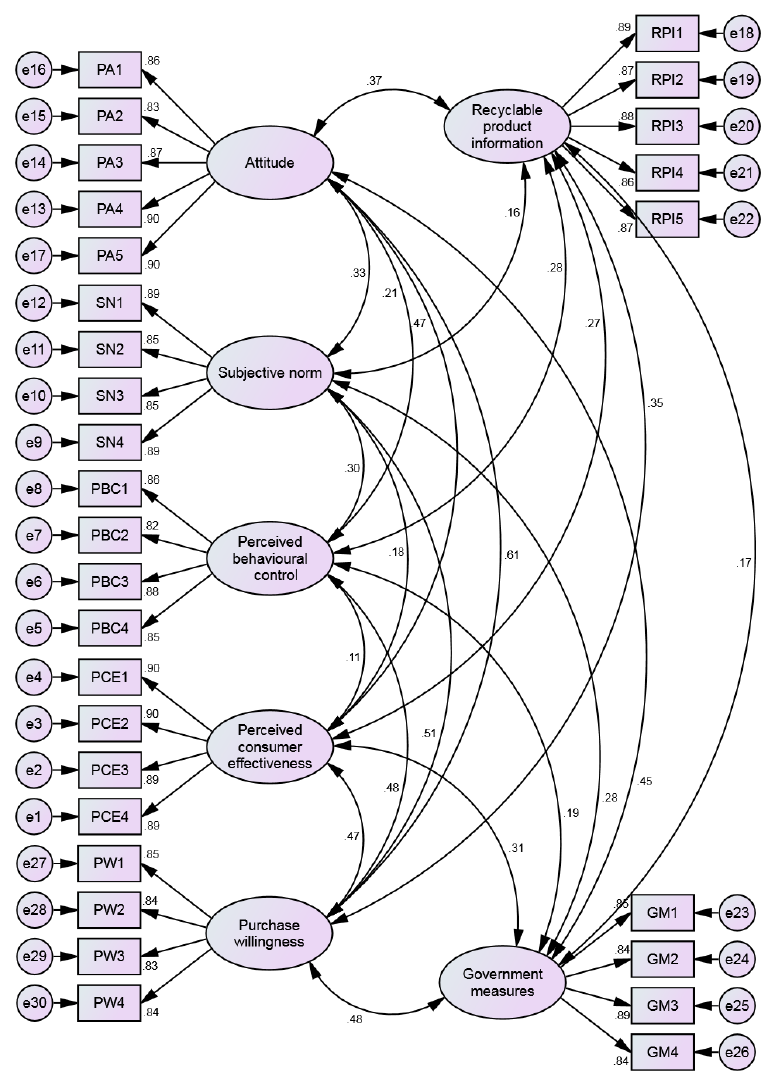
Figure 3. Standardized regression weights of the full measurement